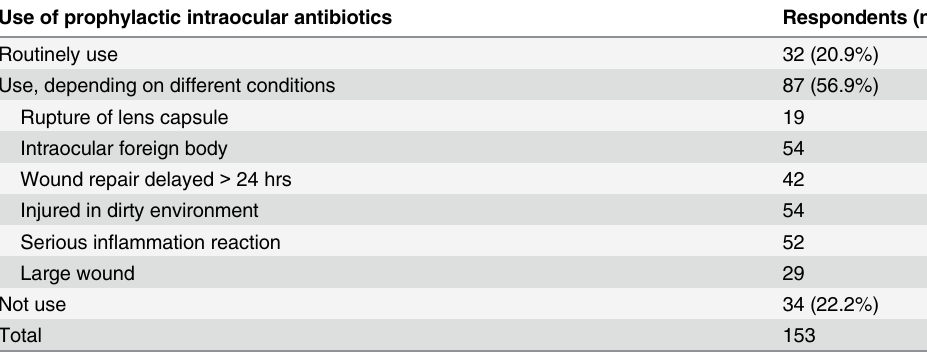
Table 2. Prophylactic intraocular injection of antibiotics at the end of primary eye repair.